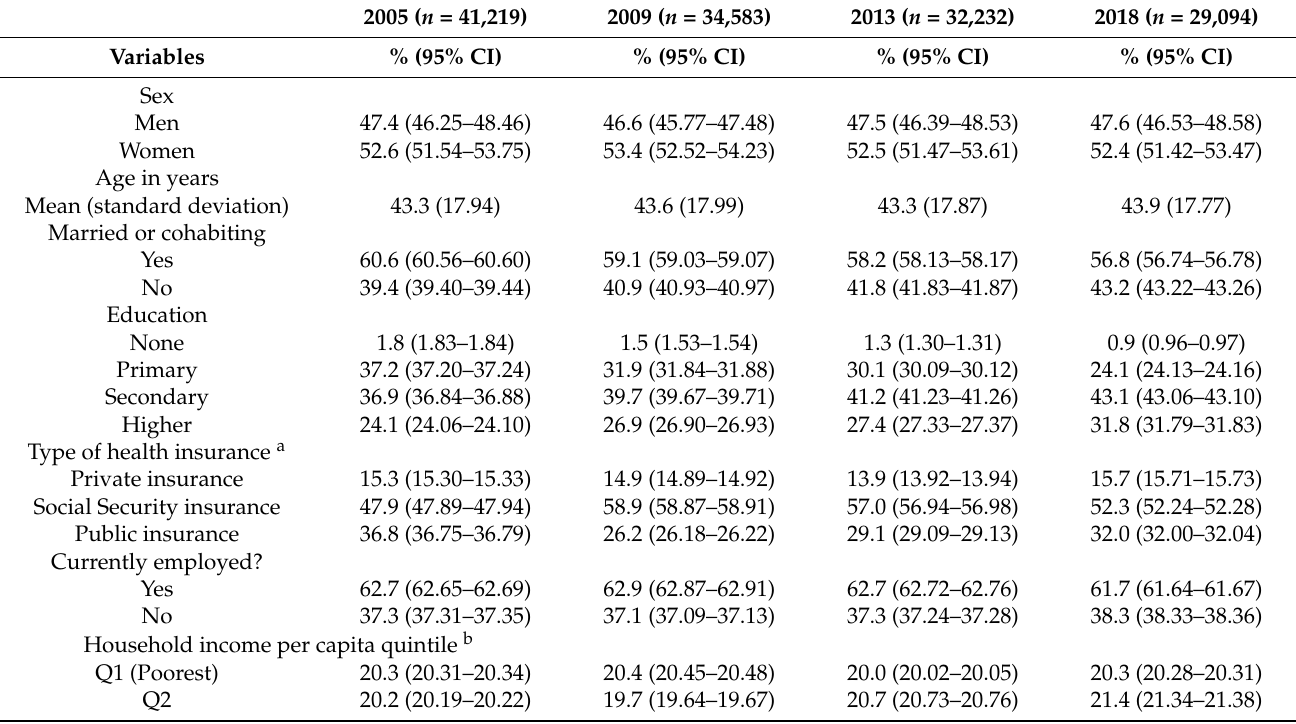
Table 1. Sociodemographic characteristics of the study sample. ENFR 2005, 2009, 2013, and